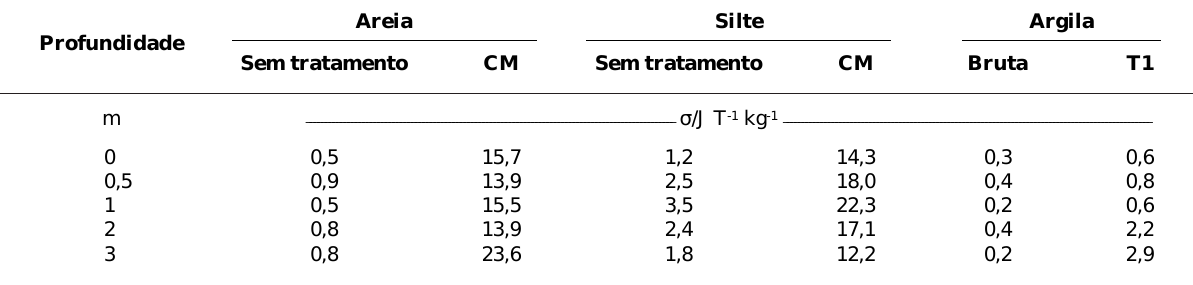
Quadro 3. Valores de magnetização de saturação em campo magnético constante de 0,3 tesla, das frações